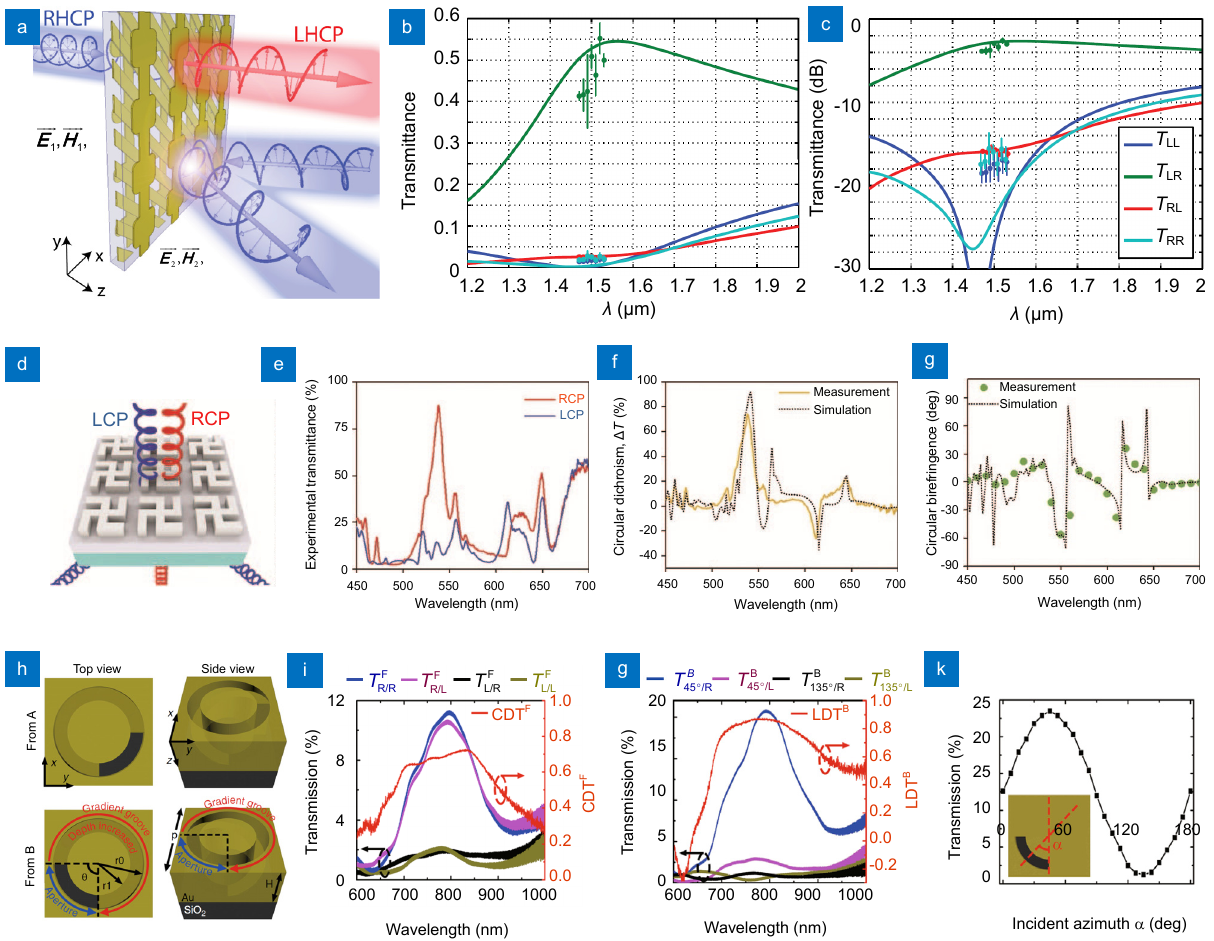
Fig. 4 | ( a ) Schematic of the metasurface that enables asymmetric transmission of CP light. Simulated (solid lines) and measured (circles) Jones matrix of the metasurface on linear ( b ) and logarithmic ( c ) scales. ( d ) Schematic of the optical response of the planar chiral metasurface. Measured zeroth-order transmission spectra ( e ), CD spectra ( f ) and circular birefringence spectra (g) of the planar chiral metasurface. ( h ) Schematic of the 3D Janus helical structures in two enantiomeric forms. ( i ) Measured transmission spectra and CDTF spectrum of the metasurface in form A for different CP incident light in the forward direction. ( j ) Measured transmission spectra and LDTB spectrum of the metasurface in form A for different LP inci- dent light in the backward direction. ( k ) Measured transmission spectrum for different azimuthal angles of the LP incident light. Figure reproduced from: (a–c) ref. 114 , American Physical Society; (d–g) ref. 148 , Nature Publishing Group; (h–k) ref. 154 , Nature Publishing